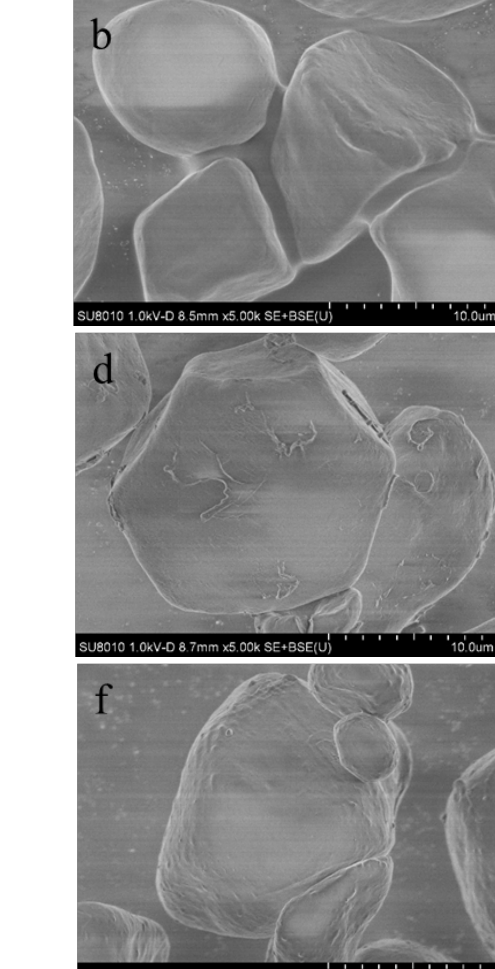
Figure 3. Di ff erential Scanning Calorimeter (DSC) heat flow curves of pure PLA and PLA / PSt, Figure 3. Differential Scanning Calorimeter (DSC) heat flow curves of pure PLA and PLA/PSt, PLA / PSt / PEG, PLA / PSt / CA, and PLA / PSt / PEG / CA blends. PLA/PSt/PEG, PLA/PSt/CA, and PLA/PSt/PEG/CA blends. Molecules 2020 , 25 , x FOR PEER REVIEW Table 3. Thermal properties of the materials.